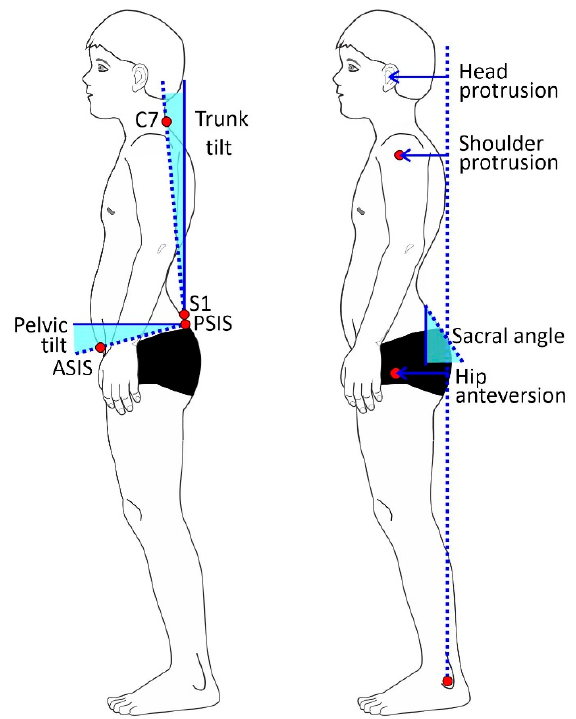
Figure 1. Analyzed posture parameters; ASIS = anterior superior iliac spine, PSIS = posterior superior iliac spine, C7 = 7th cervical vertebrae, S1 = 1st sacral vertebrae.